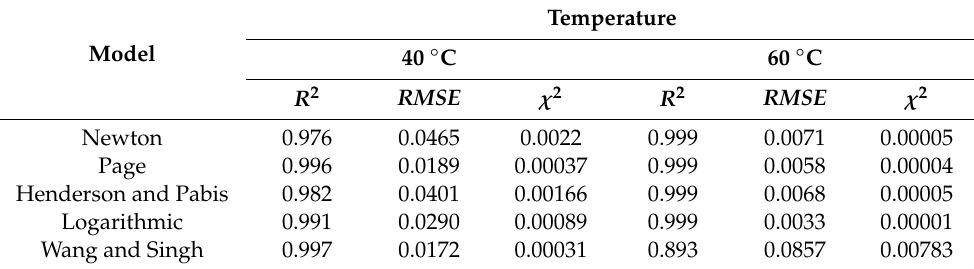
Table 4. Statistical analysis of modelsdescribingthe kinetics of air drying of Moldavian